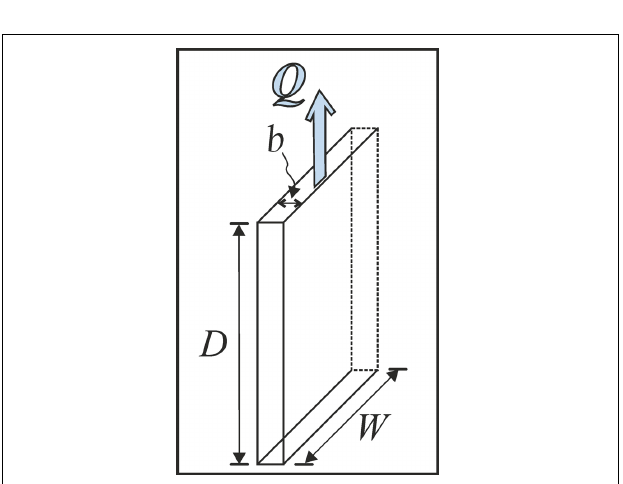
FIGURE 4 | Parallel-plate model for modeling fluid flow in a single, isolated fracture. The fracture is idealized as having smooth, parallel walls. Here Q is the volumetric flow rate, W the fracture width perpendicular to the flow direction, D the length of the dip-dimension of the fracture along which the flow takes place (cf. Figure 5 ), and b is the fracture